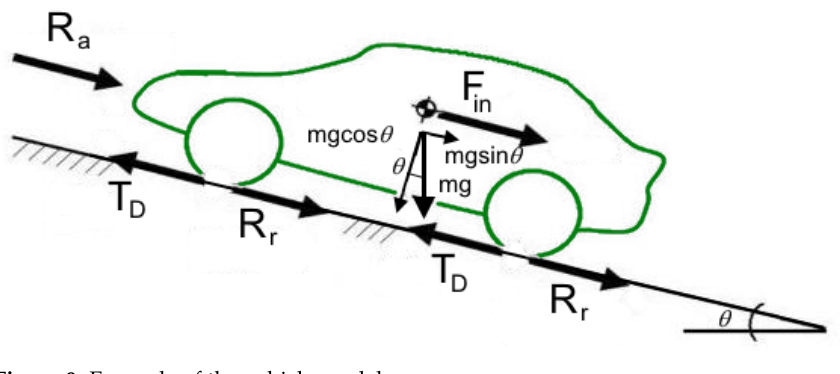
Figure 9. Example of the vehicle